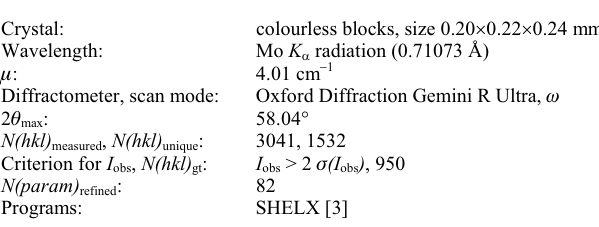
Table 1. Data collection and handling.